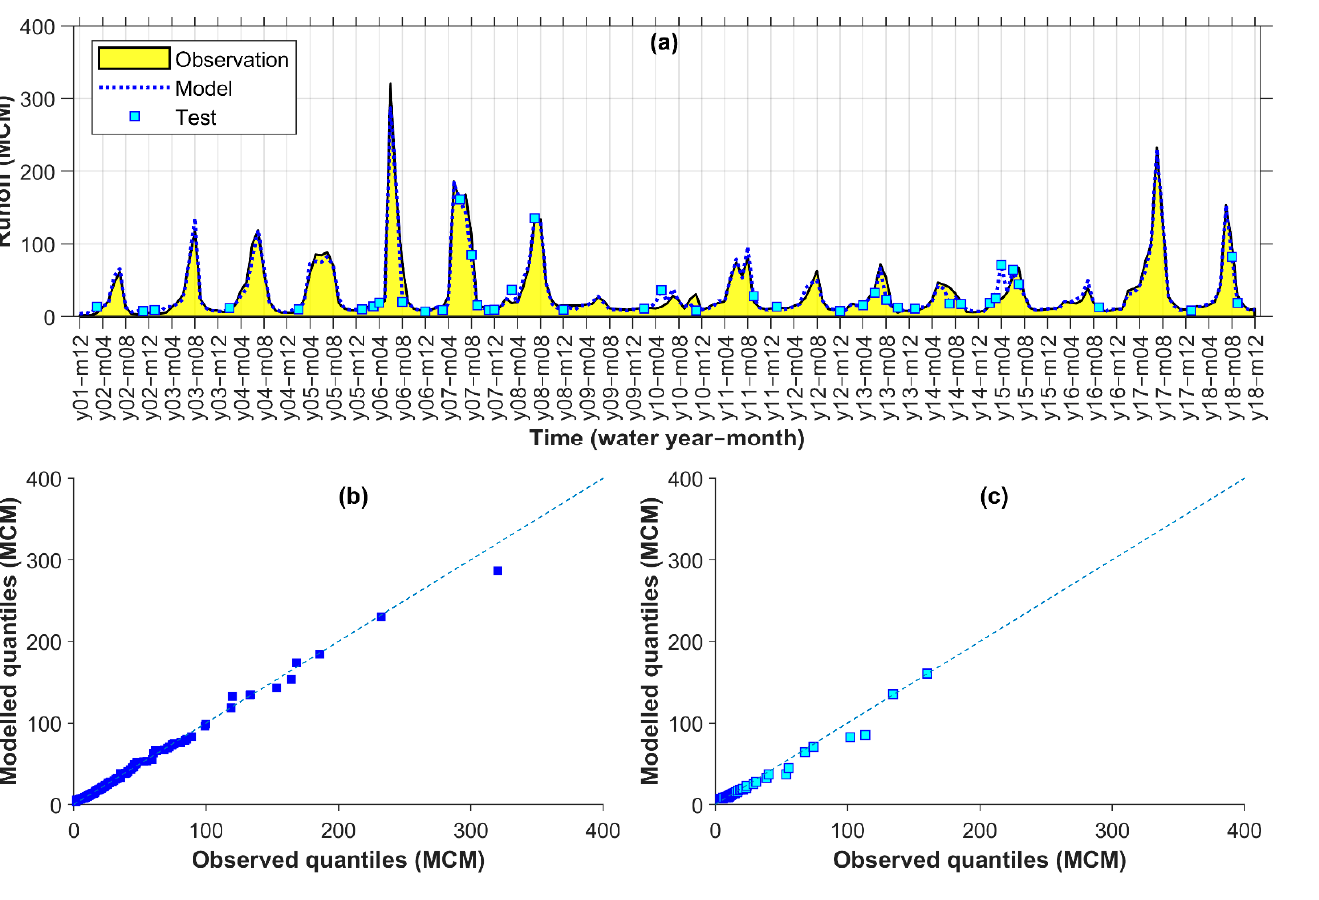
Figure 5. Qarasu observed vs. modelled monthly runoff time series ( a ) and q–q plots for calibration ( b ) and test ( c ) points (MCM: million cubic meters). Table 6. Performance criteria for the selected (Comb. 12 Lag 0–1) vs. reference model (Comb. 9 Lag 0–1) in testing points for Qarasu (RMSE and MAE are in million cubic meters while the others are unitless) and the change rate (%) between them.